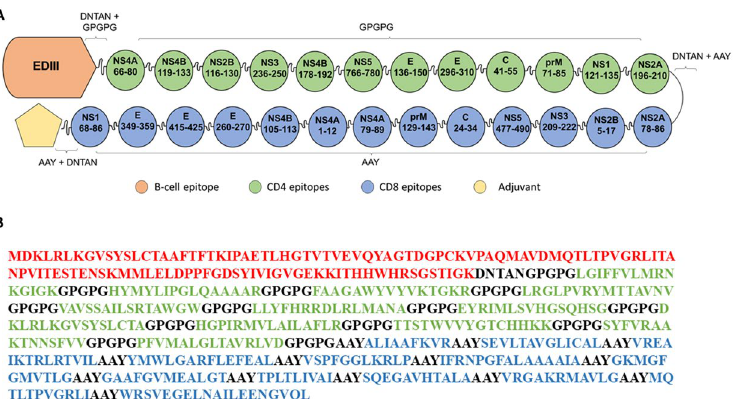
Figure 2. ZIKVac structure showing the position of CD4 (green) and CD8 epitopes (blue) envelope protein E Domain III (EDIII) and adjuvant (yellow pentagon) ( A ). The protein sequence of and ZIKVac sequence without conjugated adjuvants showing the EDIII (red), CD4 epitopes (green), CD8 epitopes (blue) and linkers (black) ( B ). DNTAN linkers were used to separate EDIII and adjuvant from the epitopes, GPGPG linkers were used between CD4 epitopes and AAY linkers between CD8